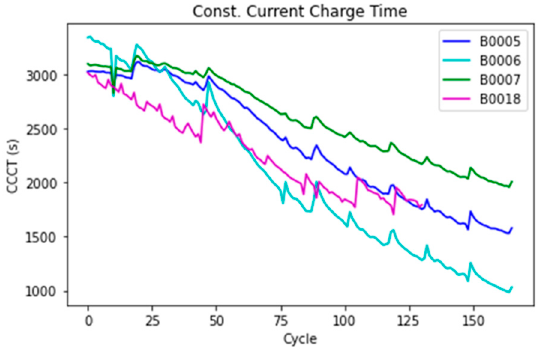
Figure 4. The constant current charge time for all cycles for the four batteries.